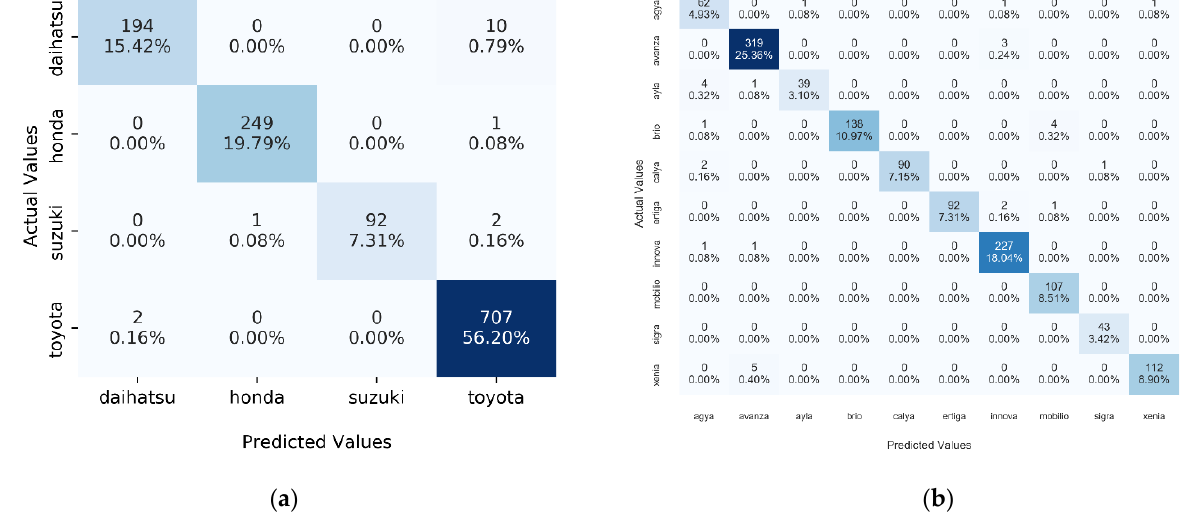
Figure 9. Confusion matrices generated based on VGG-16 MT results: ( a ) confusion matrix for vehicle brand classification task; ( b ) confusion matrix for vehicle model classification task. Table 6. Validity test result for vehicle brand classification task from VGG-16 MT.